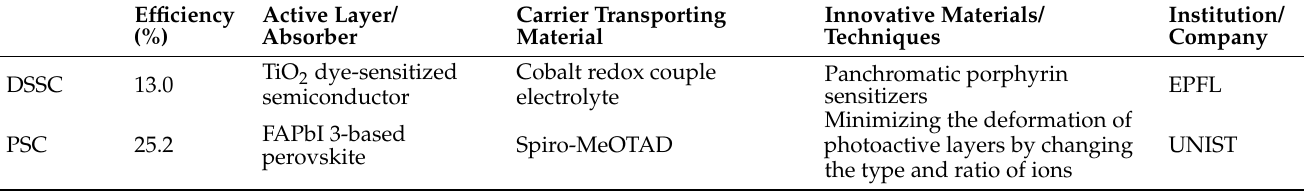
Table 6. Highest recorded efficiencies and device characteristics for DSSCs, PSCs, OPVs, and HTSCs